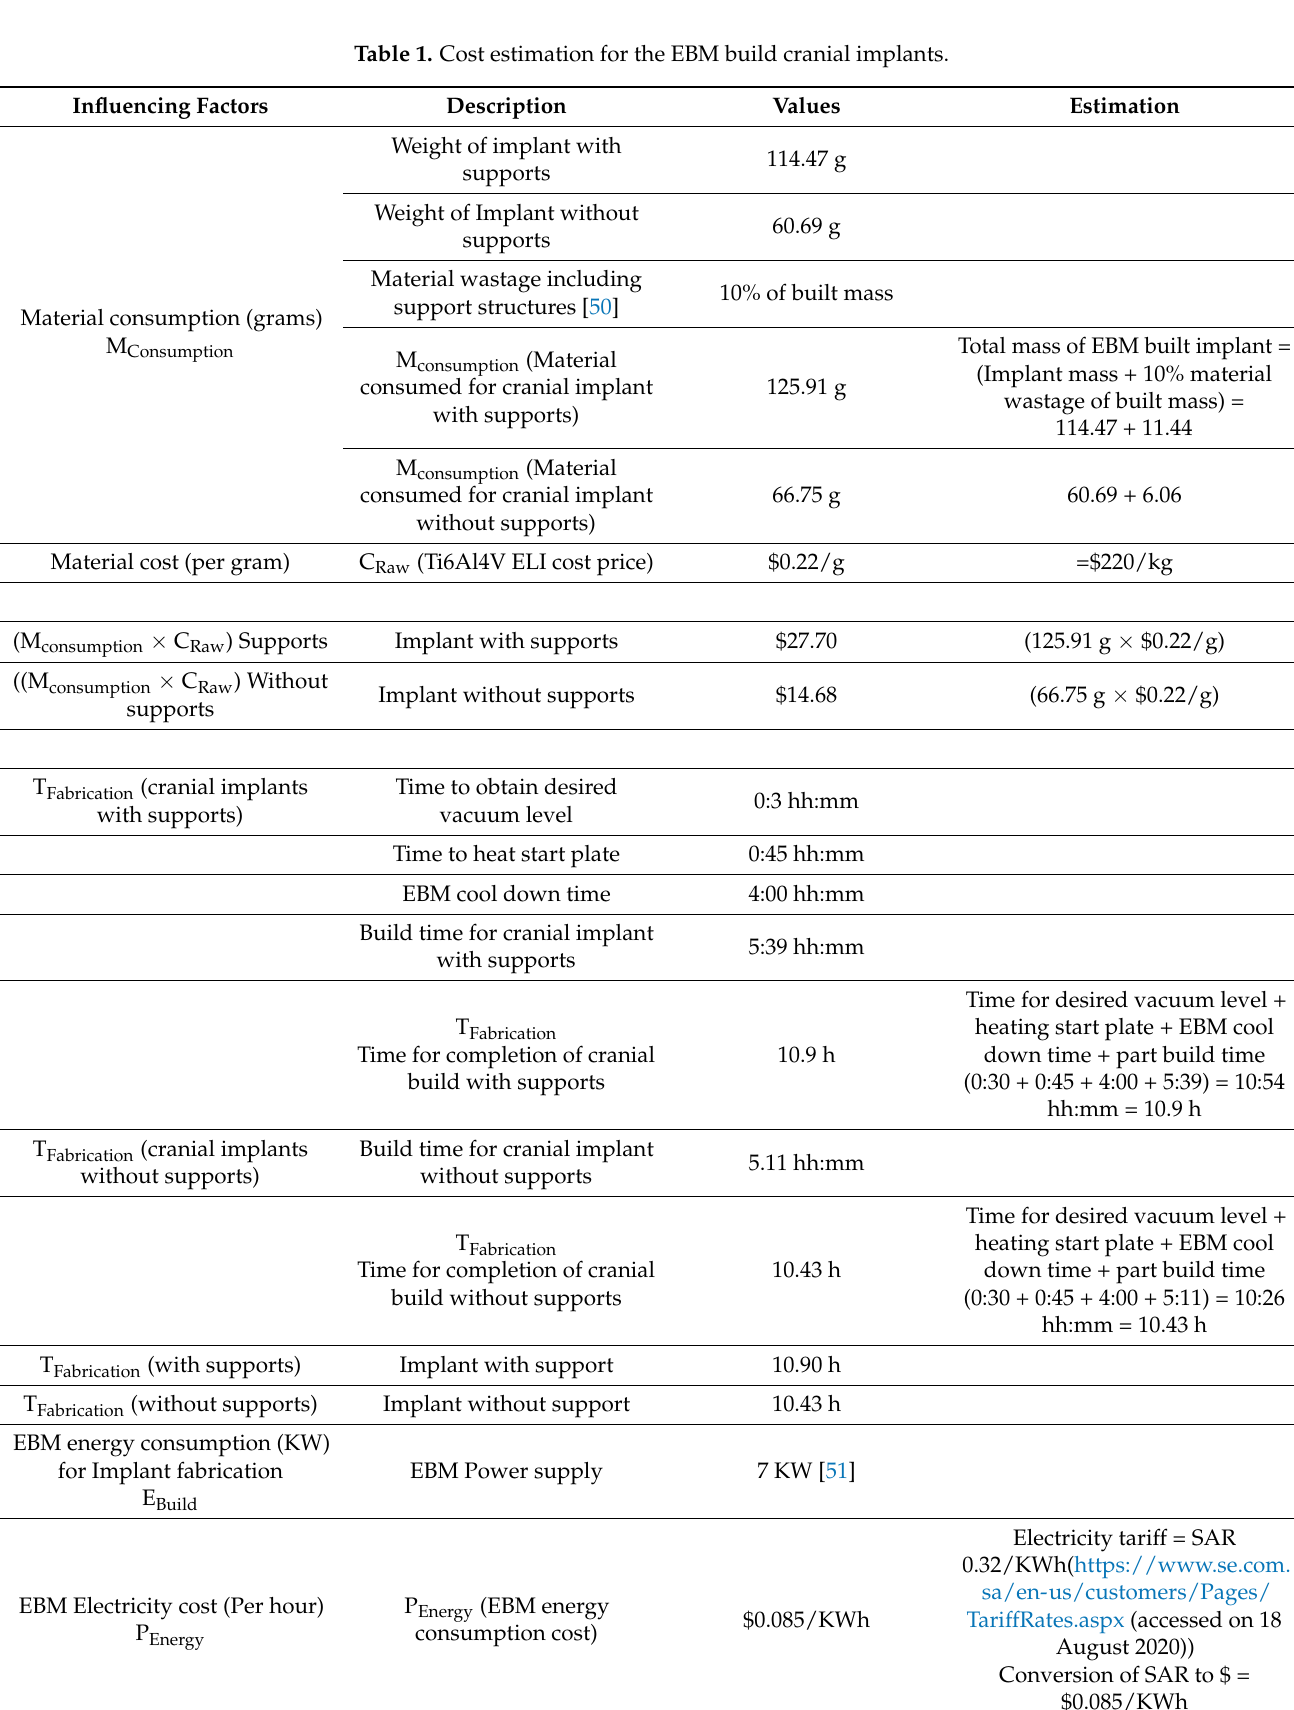
Table 1. Cost estimation for the EBM build cranial